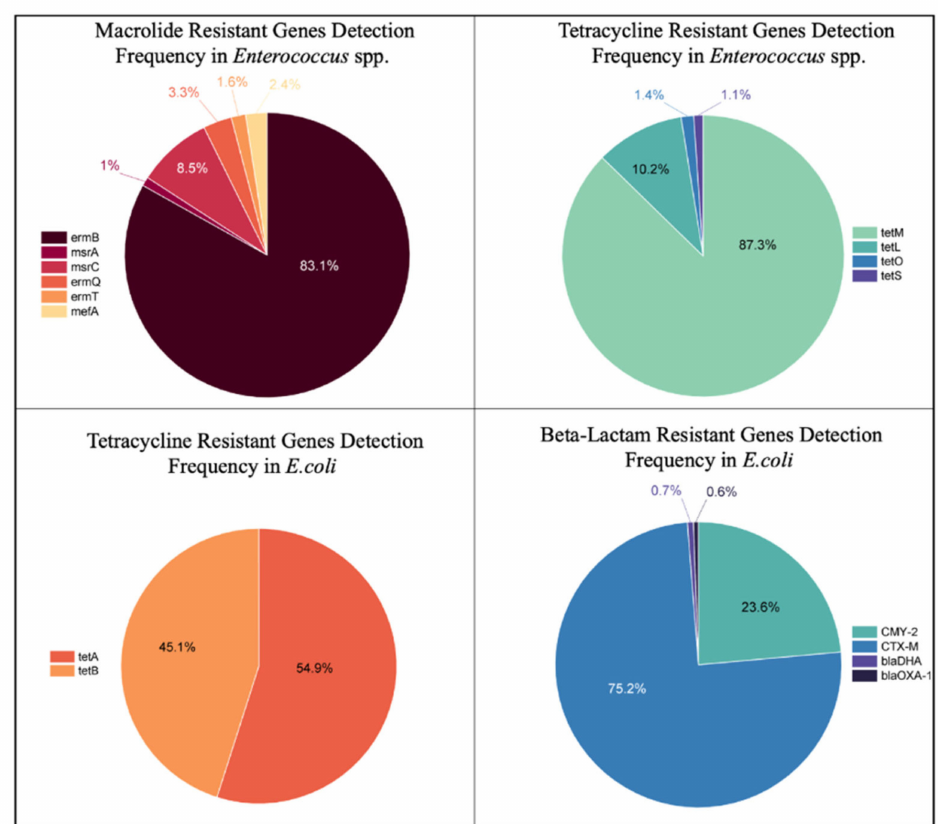
Figure 3. Detection frequencies of ARGs associated with resistance phenotypes for all E. coli and Enterococcus spp. isolates in the Bowling Green, KY urban karst groundwater